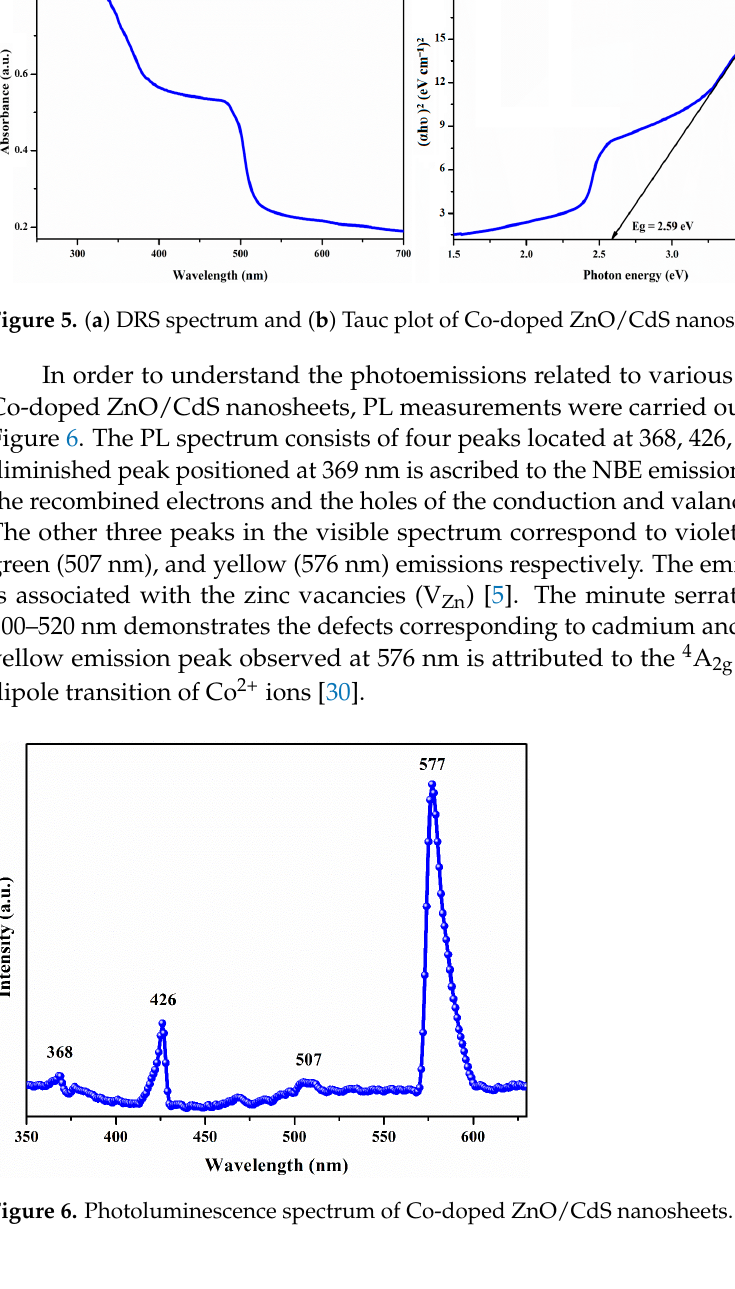
Figure 6. Photoluminescence spectrum of Co-doped ZnO/CdS nanosheets.